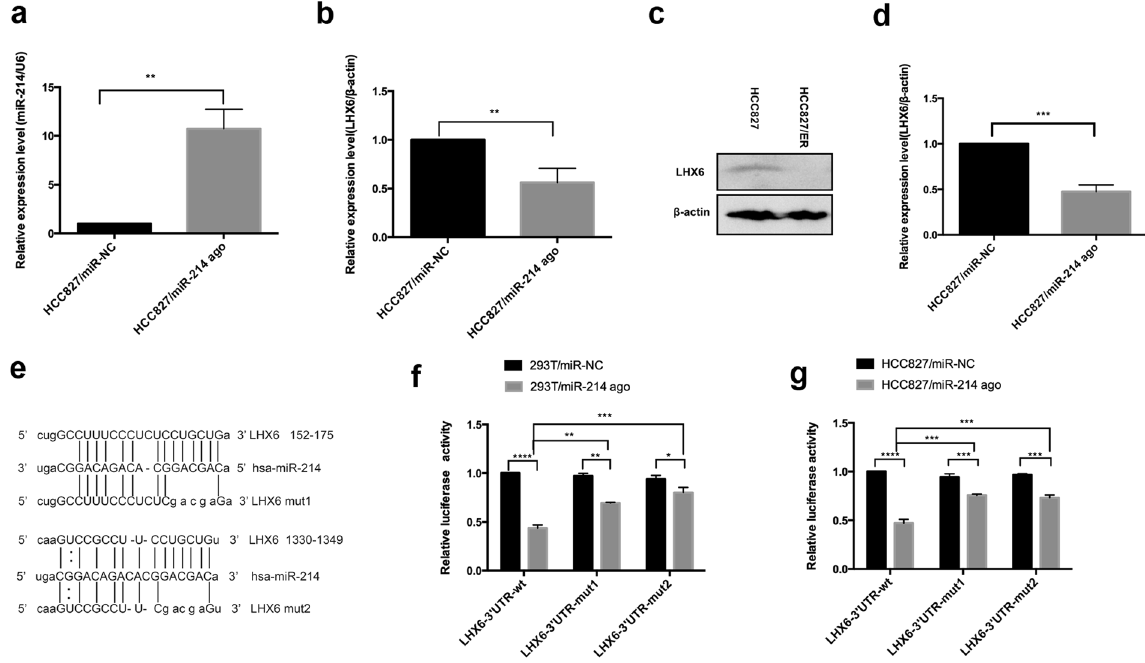
Figure 2. LHX6 is a direct target gene of miR-214. ( a ) Following 48 h transfection, qRT-PCR assay shows up- regulation of miR-214 expression in HCC827 cells transfected with miR-214 agomir than in cells transfected with miR-NC ( P < 0.01); ( b ) qRT-PCR analysis reveals down-regulation of LHX6 expression in HCC827 cells transfected with miR-214 agomir than in cells transfected with miR-NC agomir ( P < 0.01); ( c and d ) Western blotting assay reveals down-regulation of LHX6 protein expression in HCC827 cells transfected with miR-214 agomir than in cells transfected with miR-NC agomir ( P < 0.0001); ( e ) Sequences of the 3 ′ UTR region of the LHX6 gene matching to miR-214. The 5 ′ terminus of miR-214, matched by the seed sequences of the LHX6 3 ′ UTR region, is ligated to the dual-luciferase reporter vector psi-check2 to construct wild-type (LHX6-3 ′ UTR/wt) and mutant (LHX6-3 ′ UTR/mut1 and LHX6-3 ′ UTR/mut2) dual-luciferase reporter genes; ( f and g ) Following co-transfection in 293 T (F) and HCC827 cells (G) with 50 nM miR-NC or miR-214 agomir in combination with 0.1 μ g LHX6-3 ′ UTR-wt, LHX6-3 ′ UTR-mut1 or LHX6-3 ′ UTR-mut2 for 24 h, dual-luciferase reporter assay reveals a significant lower relative luciferase activity of LHX6-3 ′ UTR/wt in cells transfected with miR-214 agomir than in cells transfected with miR-NC, while significantly up-regulated relative luciferase activities of LHX6-3 ′ UTR/mut1 ( P < 0.001) and LHX6-3 ′ UTR/mut2 ( P < 0.001) were measured than that of LHX6-3 ′ UTR/wt in HCC827 and 293 T cells transfected with miR-214 agomir. All data are expressed as mean ± SD from three independent experiments. * P < 0.01; ** P < 0.001; *** P < 0.01; **** P <